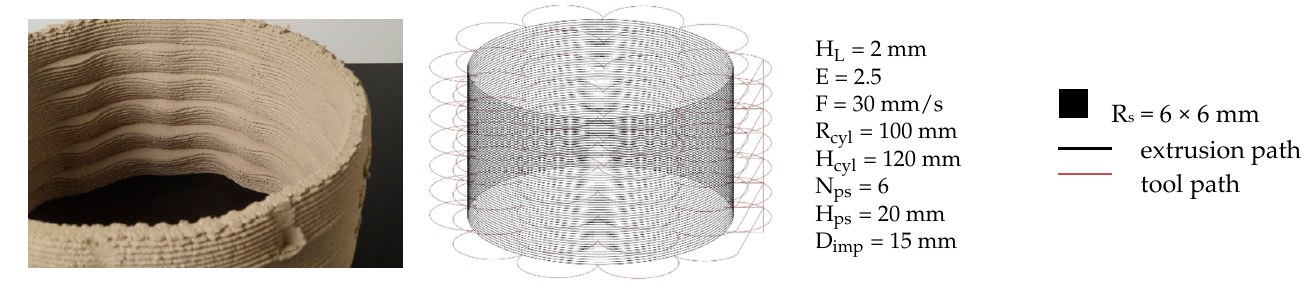
Table 3. Comparison of Grasshopper modelling as complex path instruction (material extrusion + tool) and materialized implementation with square material stencil in the LDM of clay.